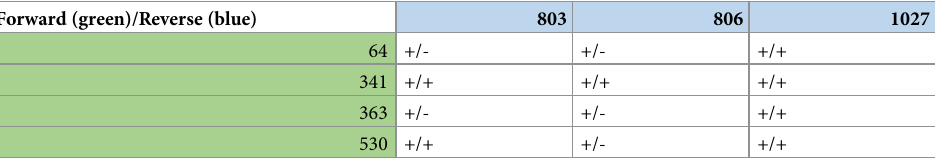
Table 2. The table indicates whether different combinations of 16S primers resulted in an amplification when reacting with bacterial or human genome (+: positive reaction with E . coli /human genome,; -: no amplification with E . coli /human genome, green = forward, blue = reverse primer).